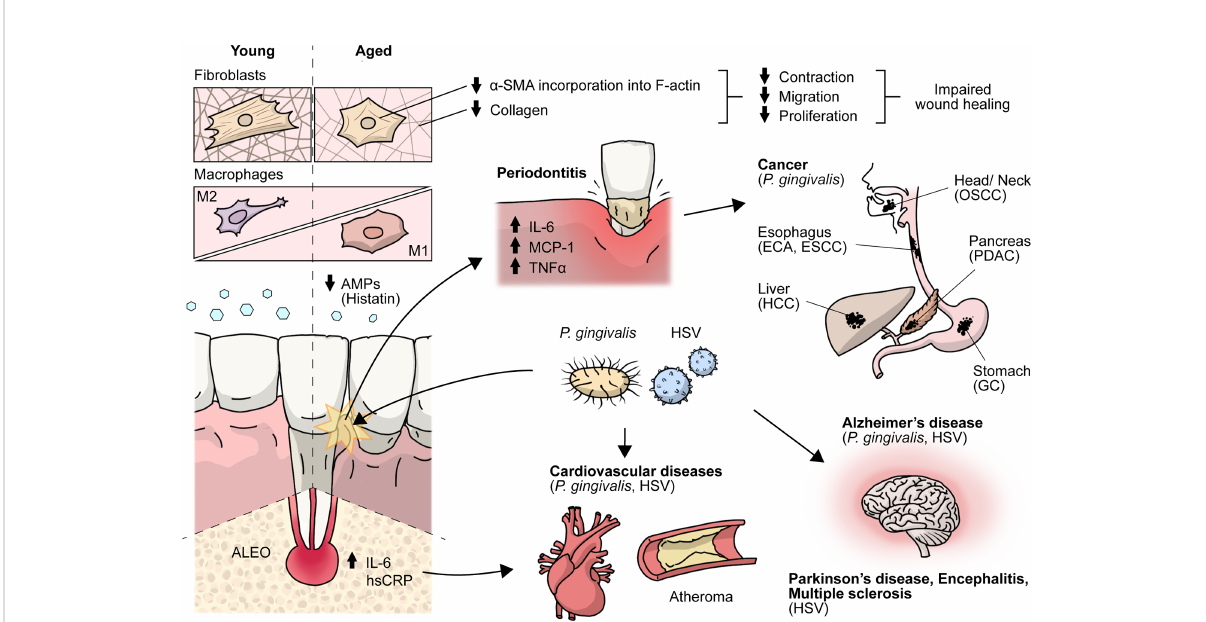
FIGURE 1 Effects of aging on the periodontium and antimicrobial peptides. Crosstalk between HSV and P.gingivalis with cancer, encephalitis, multiple sclerosis, cardiovascular, Parkinson ’ s, Alzheimer ’ s and periodontal diseases. During aging there is an impaired gingival wound healing. Aged gingival fi broblasts show decreased cell migration, proliferation and contraction, and lower a -SMA is incorporated into actin stress fi bers and aged macrophages show altered acquisition offunctional phenotypes, HSV and P . gingivalis have been associated with periodontal, cardiovascular and Alzheimer ’ s diseases. AMPs, antimicrobial peptides; ALEO, apical lesions of endodontic origin; hsCRP, high-sensitive C-reactive protein; a -SMA, alpha-smooth muscle actin; OSCC, oral squamous cell carcinoma; ESCC, esophageal squamous cell carcinoma; PDAC, pancreatic ductal adenocarcinoma; HCC, hepatocellular carcinoma; GC, gastric